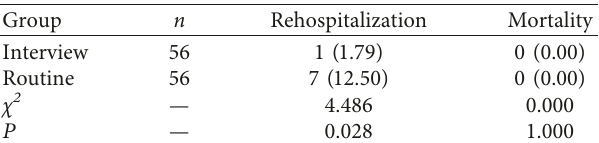
Table 4: Comparison of the prognosis of the two groups of patients ( n (%)).